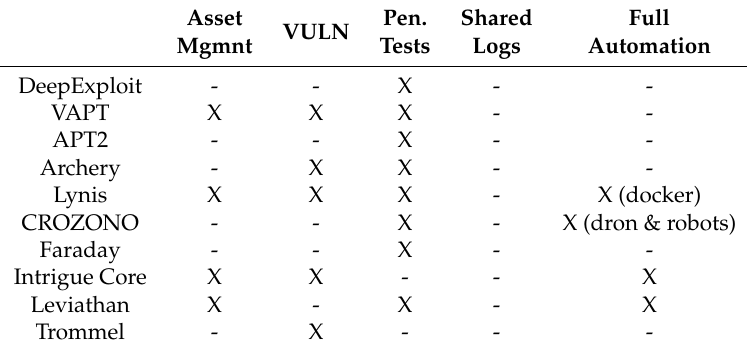
Table 1. Comparison of tools to automate software asset management (SWAM) and/or vulnerability management (VULN). Asset Pen. Shared Full VULN Mgmnt Tests Logs Automation DeepExploit - -